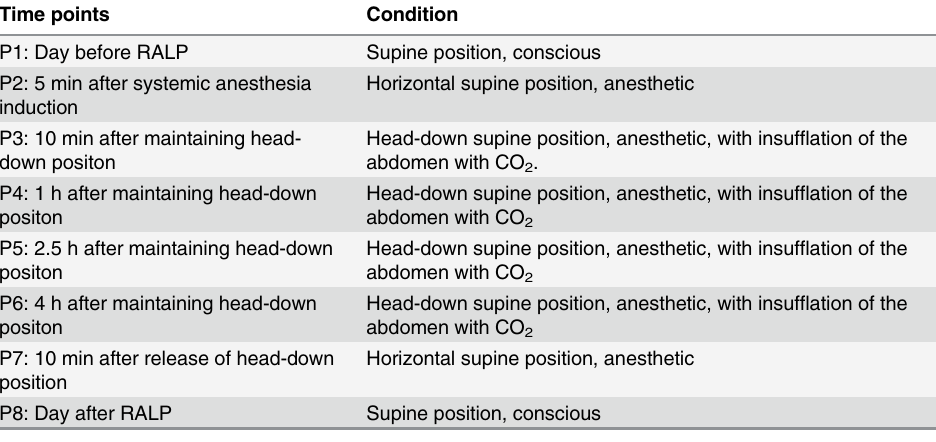
Table 1. Time points of intraocular pressure measurements and condition of the